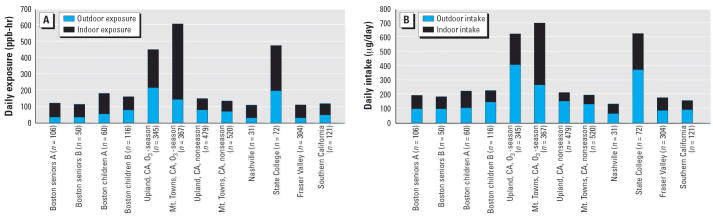
(A) Calculated indoor and outdoor ozone exposures. (B) Calculated indoor and outdoor ozone intakes (see text for details). Data from Boston, Massachusetts: Sarnat et al. (2005); Upland and Mt. Towns, California: Geyh et al. (2000); Nashville, Tennessee: Lee et al. (2004); State College, Pennsylvania: Liu et al. (1993); Fraser Valley, British Columbia, Canada: Brauer and Brook (1995); Southern California: Linn et al. (1996).